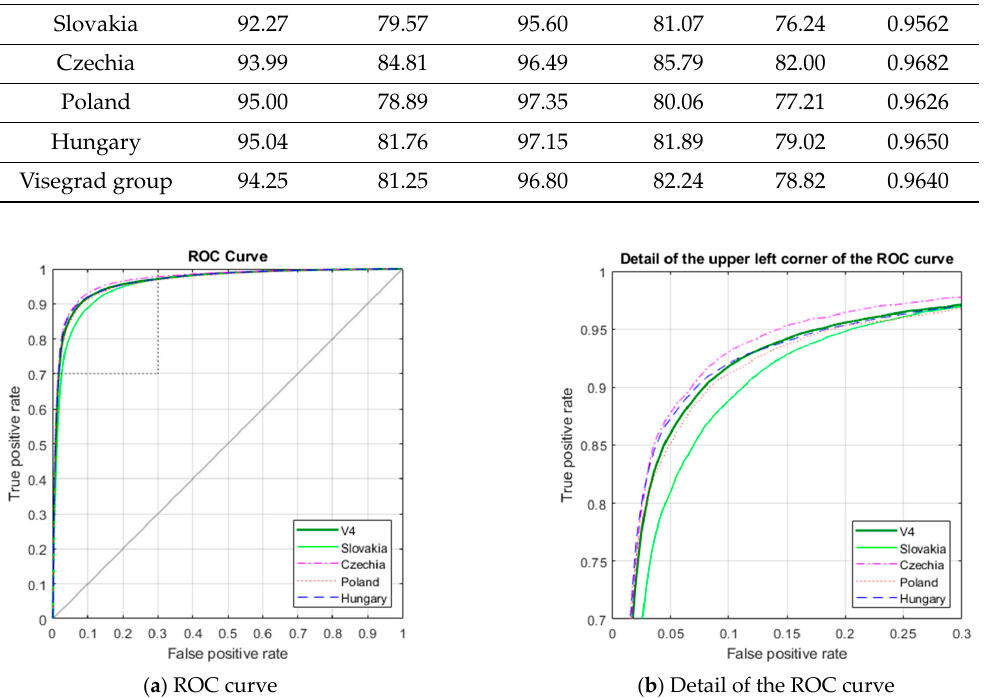
Figure 8. The ROC curve of the final model in the Visegrad group.